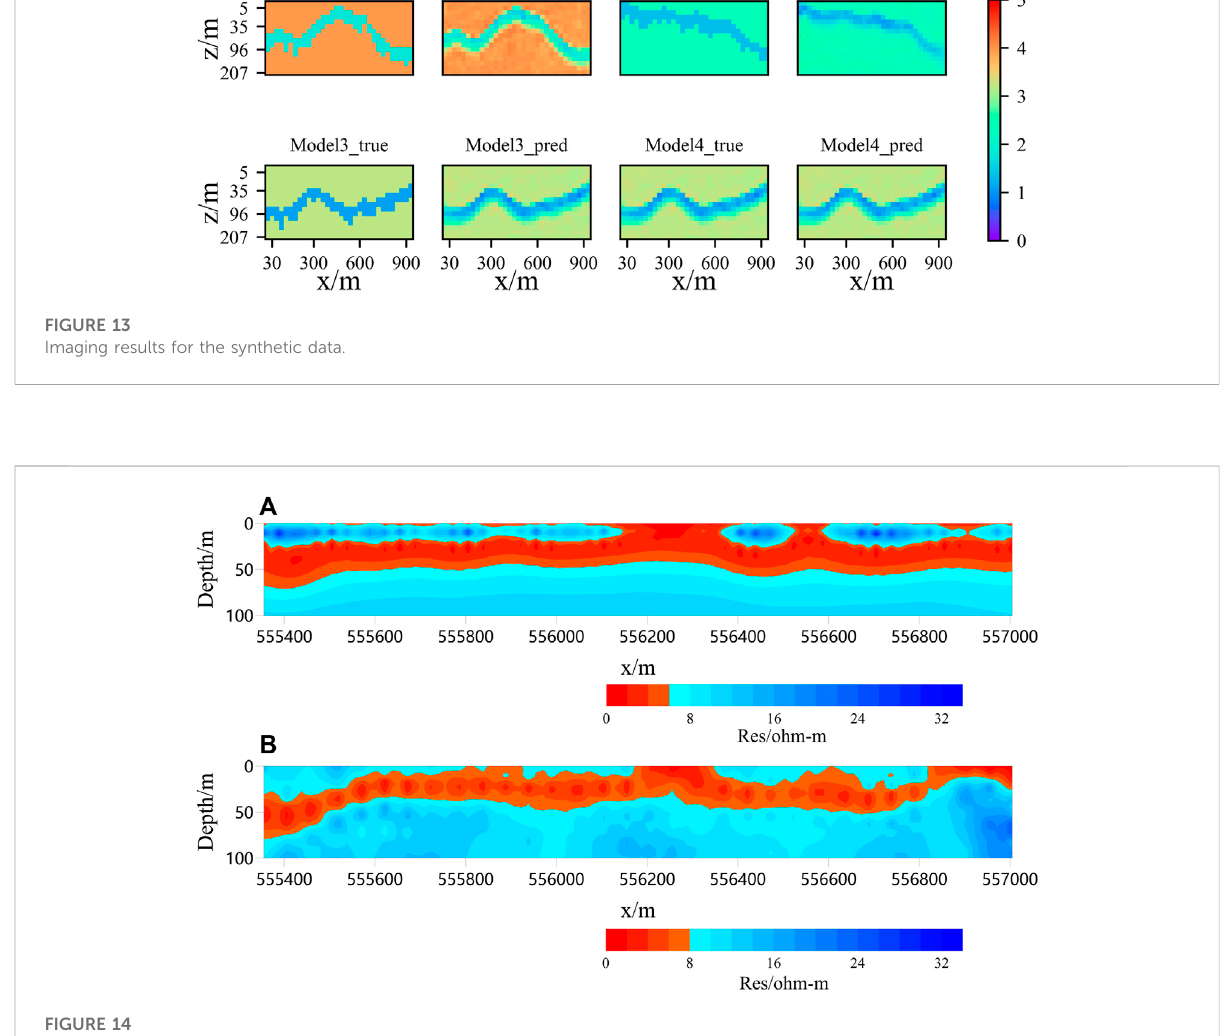
ImagingresultsofsurveydataacquiredinBynesetarea,NorwayincomparisontotheinversionresultsofLiuetal.(2018). (A) Inversionresults (B) U-net